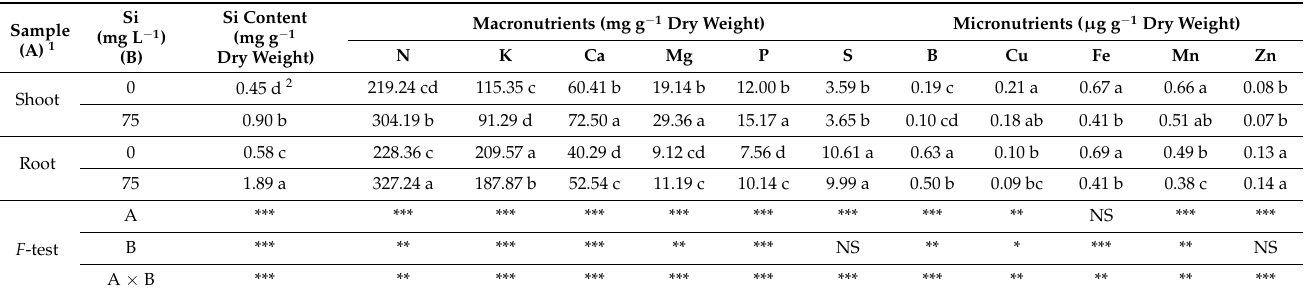
Table 3. Influence of 30 days of silicon application on mineral content in both shoot and root of coffee plants.